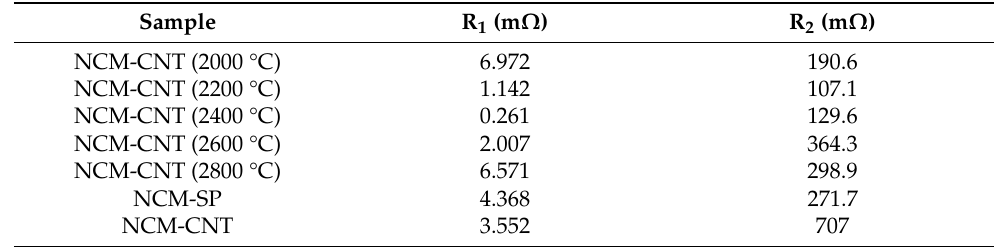
Table 2. Cell EIS parameters for MWNTs (slurry) cathodes with different annealing temperatures. Sample R 1 (m Ω